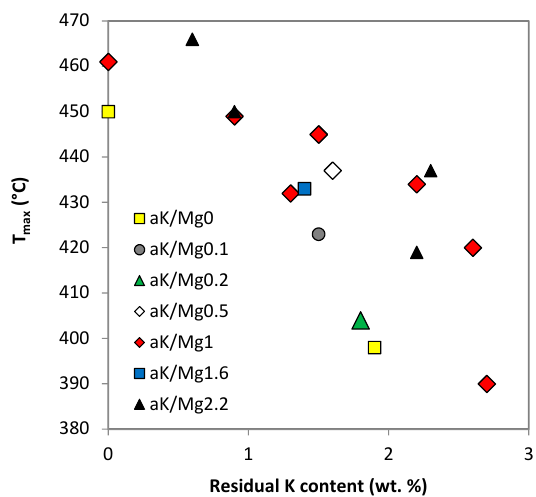
Figure 6. Dependence of T max of the high-temperature peak from the temperature-programmed reduction by hydrogen (TPR-H 2 ) measurement on the real K content for K / Co-Mg-Mn-Al mixed oxide